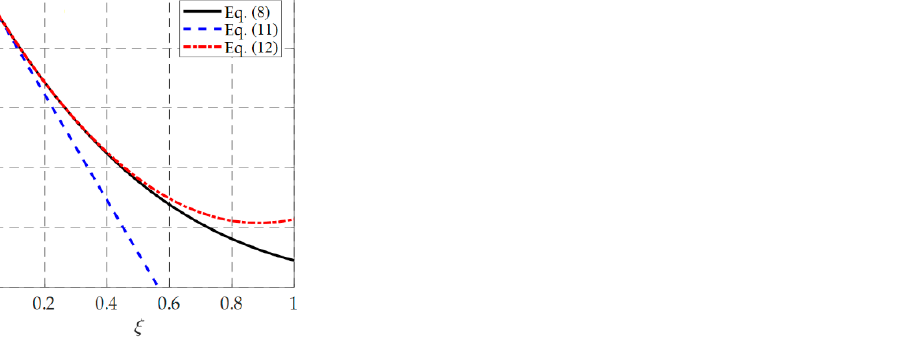
Figure 3. Schematic diagram for delta-shoreline formation owing to sediment supply from the river as a point source.